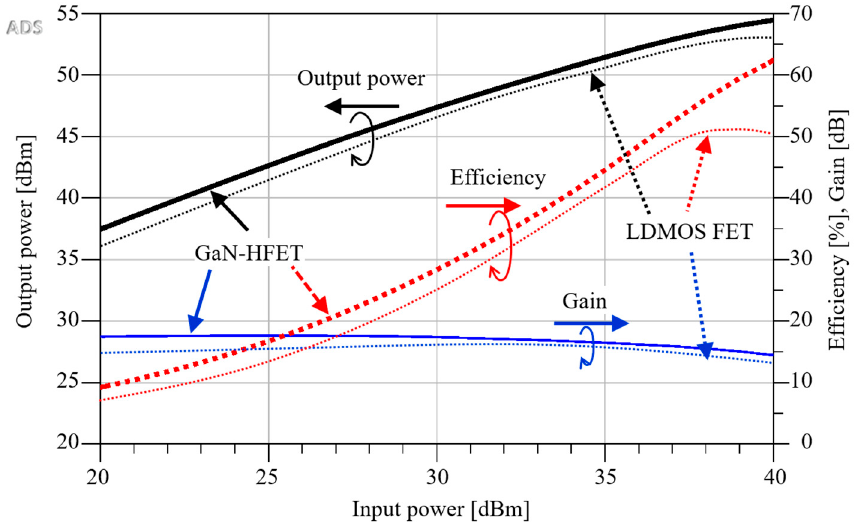
ffi ciency, and gain of the power Figure 3. Simulated power, efficiency, and gain of the power amplifier. Figure 3. Simulated power, e Figure 3. Simulated power, efficiency, and gain of the power amplifier.